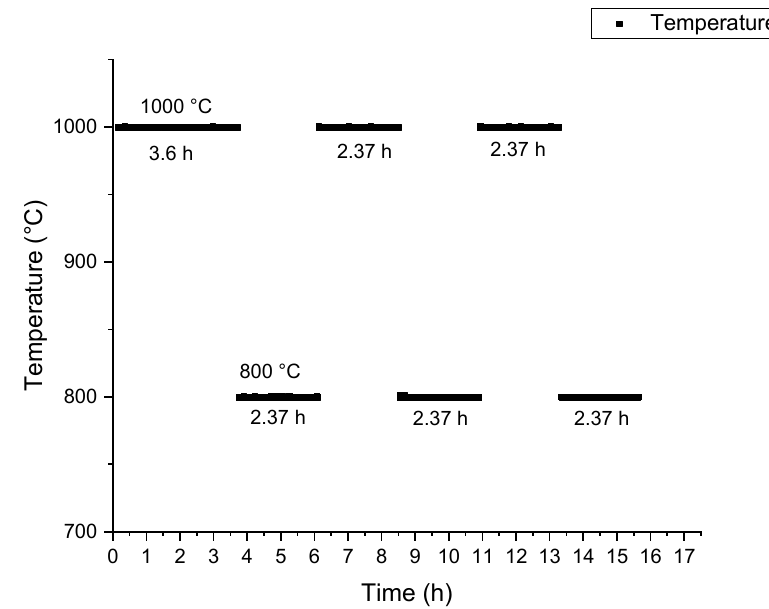
Figure 1. Thermal solicitation for the sample Ni30Cr-R0.58.